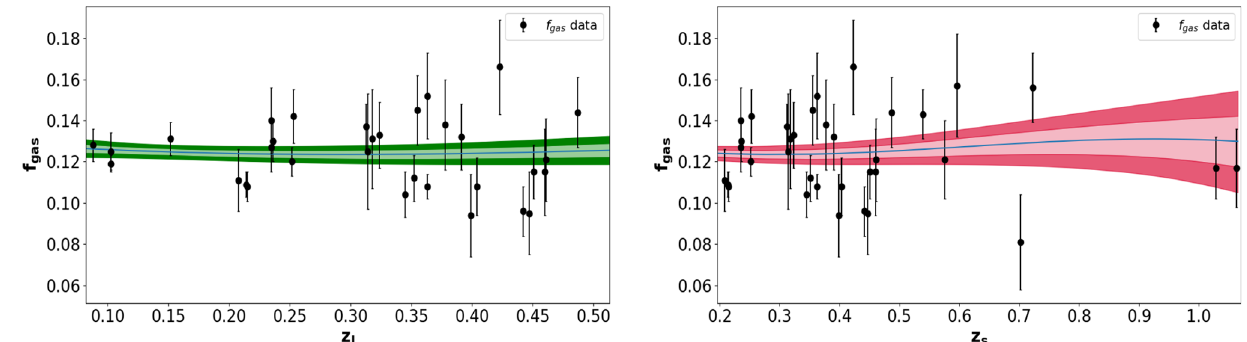
Fig. 1 (Left) Reconstruction of the gas mass fraction at z l for the Inter- mediate Mass range sample using Gaussian Process Regression. The green shaded area indicates 1 σ and 2 σ error bands. (Right) Recon-